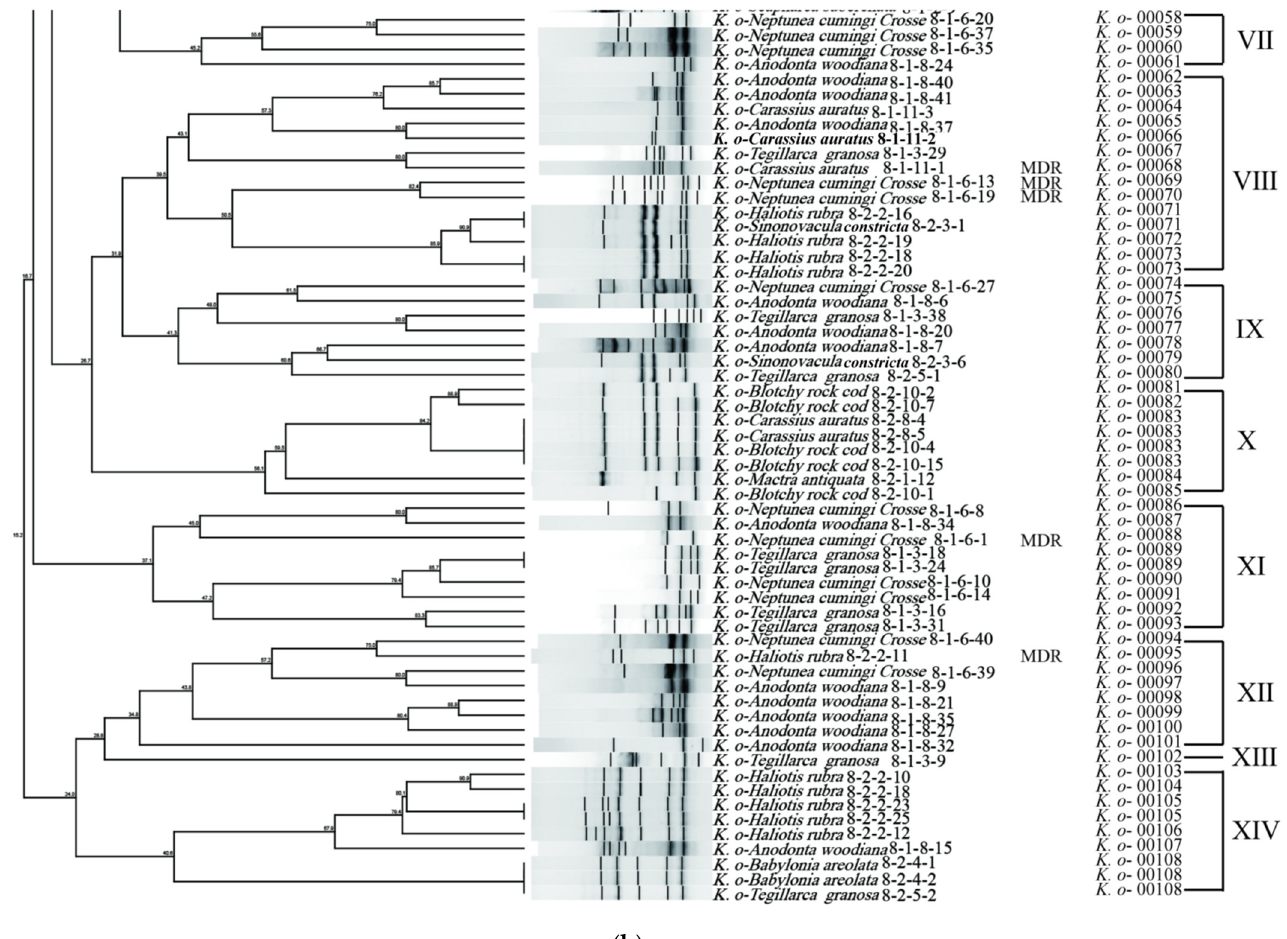
Figure 5. ERIC-PCR-based genotyping of the 125 K. oxytoca isolates. Approximately 23.2% ( n = 29) of the 125 K. oxytoca isolates shared 12 ERIC-genotypes. For example, four isolates with the ERIC-genotype K. o - 00044 were derived from S. constricta , suggesting near-present relatives or clonal relatedness. Additionally, there were four ERIC-genotypes ( K. o - 00011, K. o - 00071, K. o - 00083, and K. o - 00108) containing the isolates derived from different species of aquatic animals. For example, the two isolates